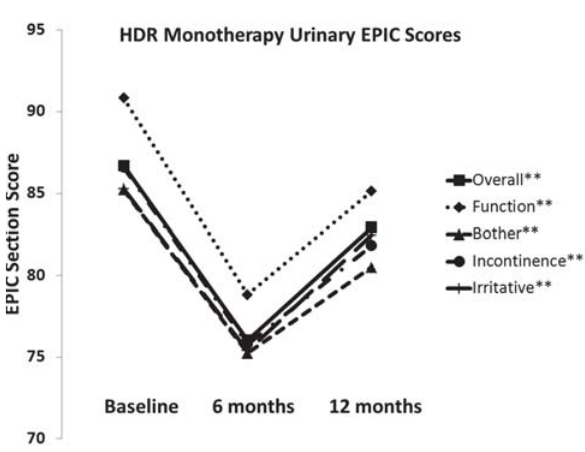
Figure 1 - EPIC urinary overall, function, bother, incontinence, and irritative/obstructive scores before HDR brachytherapy monotherapy and 6 and 12 months after treatment.